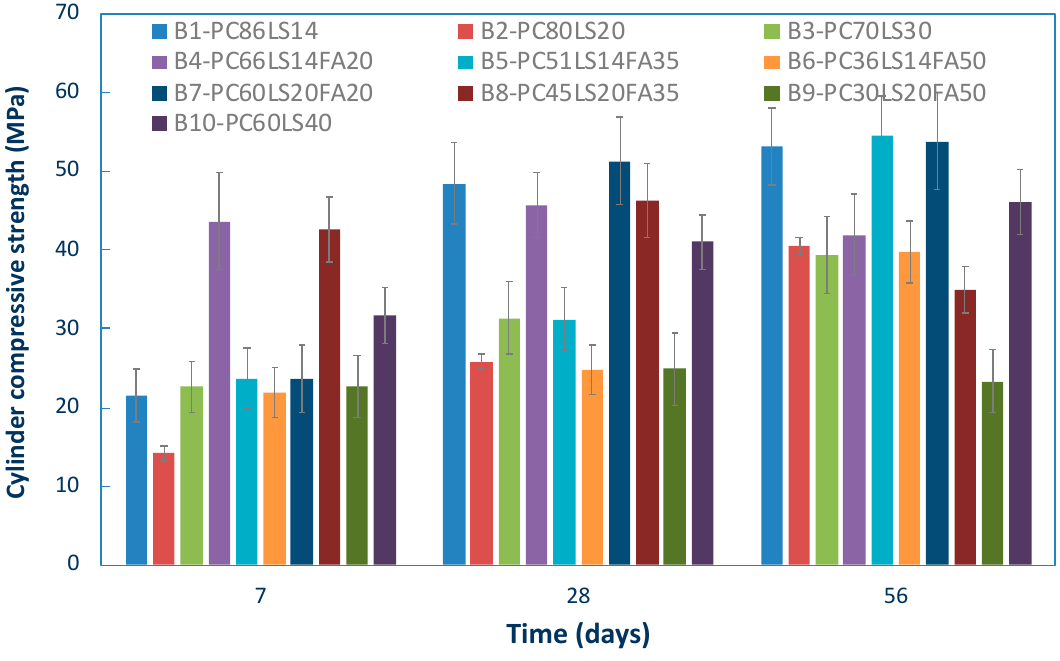
Figure 10. Cylinder compressive strength of binary and ternary cementitious matrices (B1-B10).